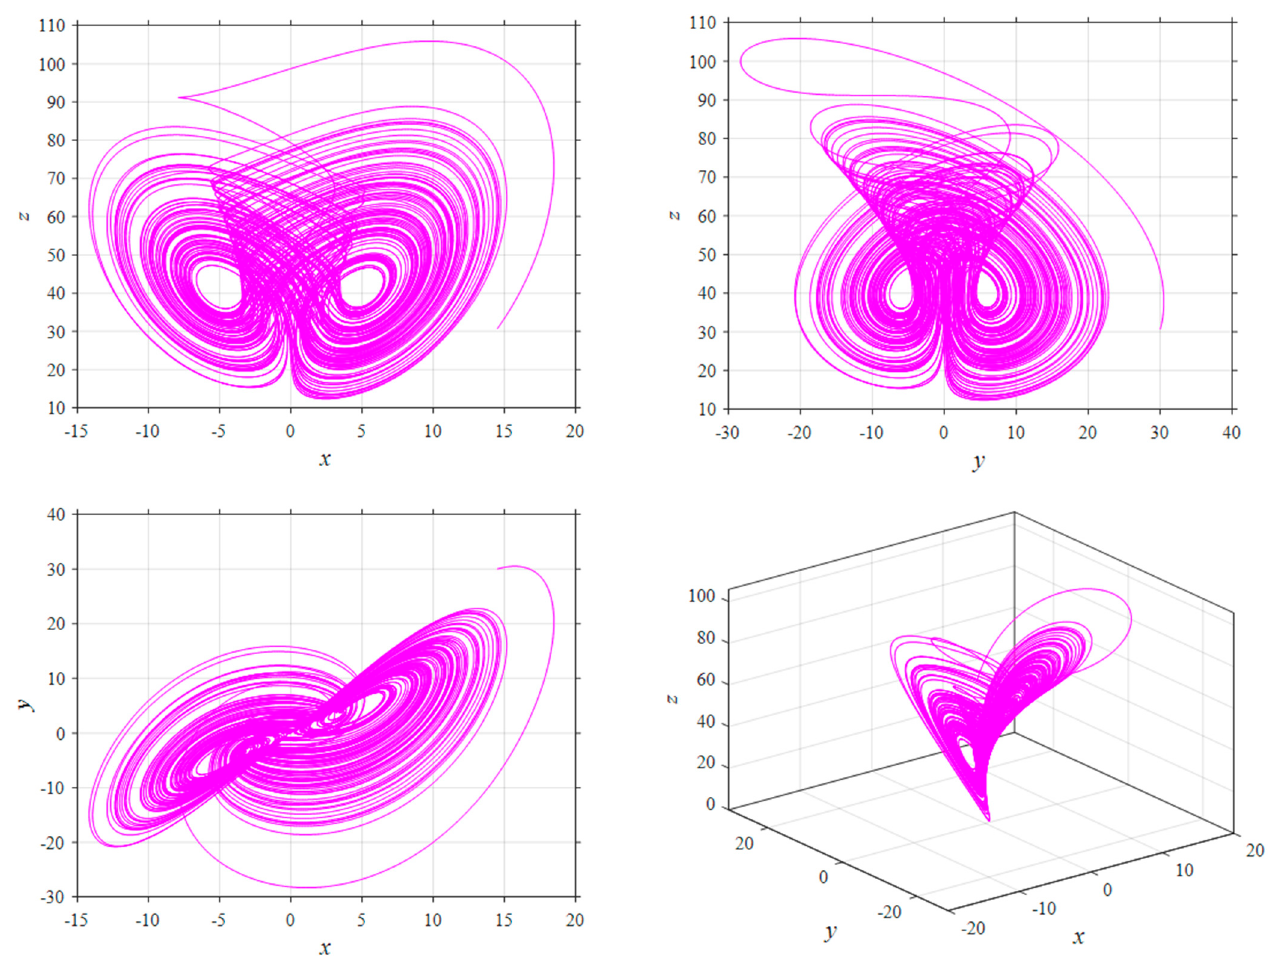
Figure 5. Fractional Liu system chaotic attractor using SINC-DQM with time ( T = 100 ) and fraction λ = 0.8, γ = 0.99, a 1 = 10, a 2 = 2.5, a 3 = 40, k = 1, h = 4, and x ( 0 ) = 0.2, y ( 0 ) = 0.0, z ( 0 ) = 0.5